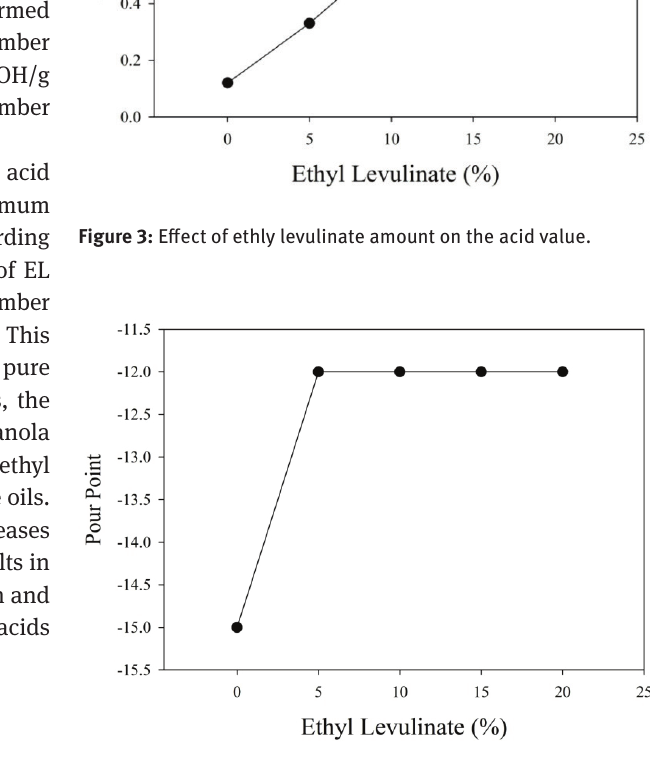
Figure 4: Effect of ethly levulinate amount on the pour point.